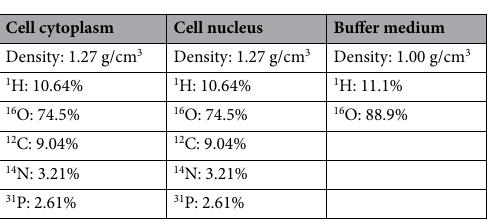
Cell cytoplasm Cell